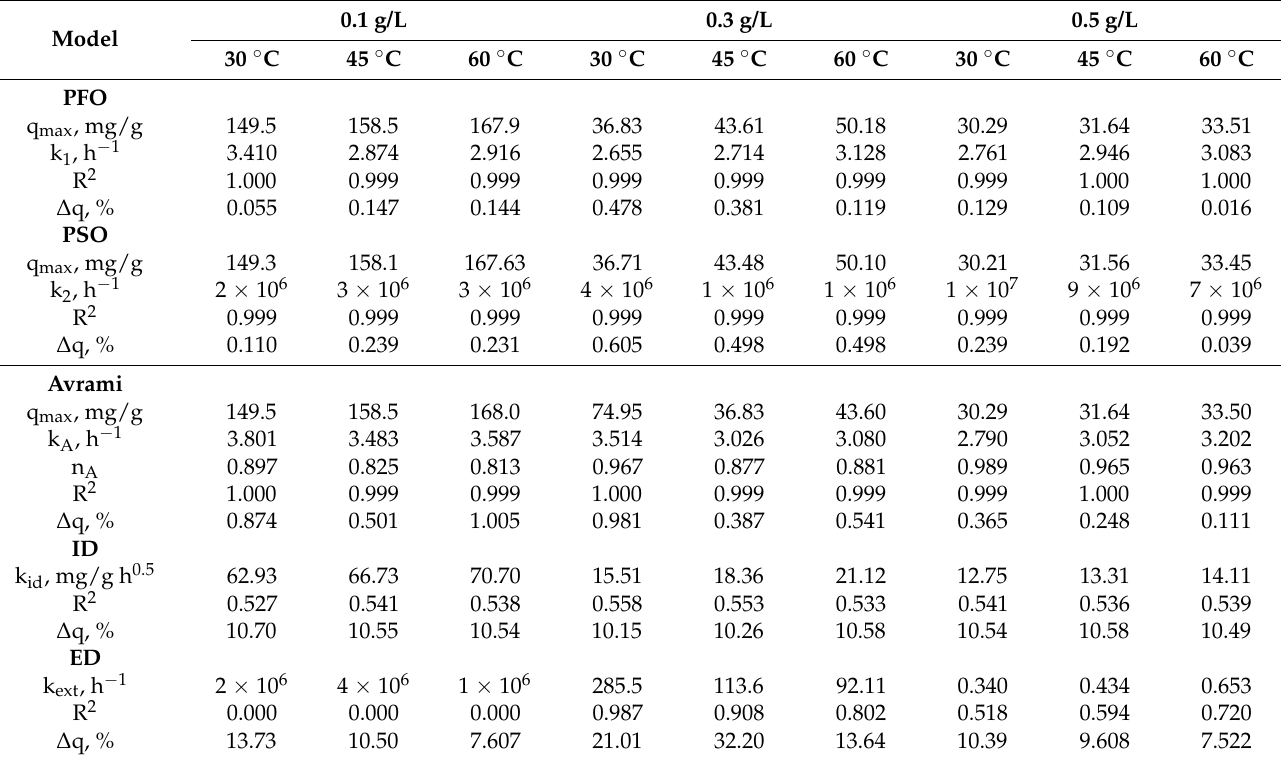
Table 9. Kinetic parameters for GV adsorption with